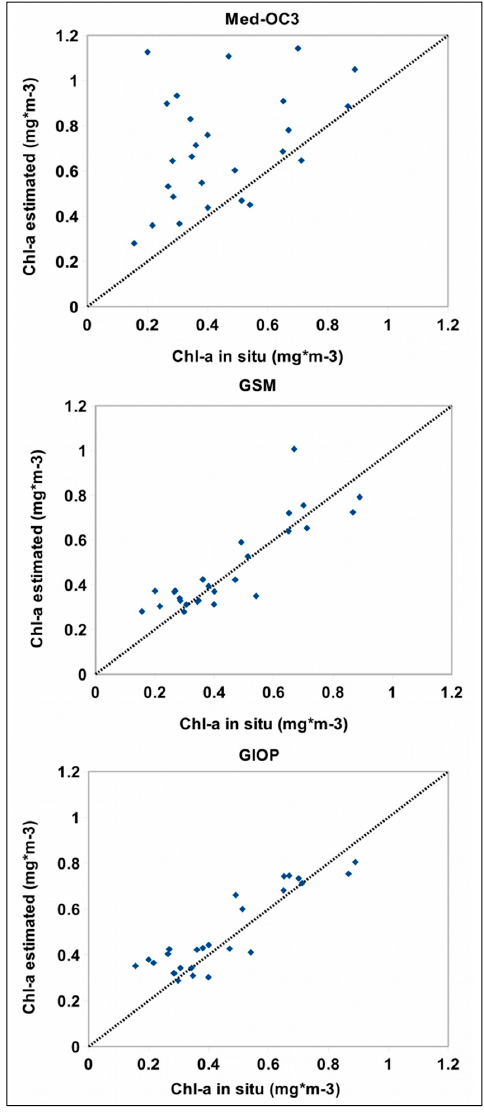
Figure 4. Scatter plots of in situ versus MODIS-A chl-a values for Med-OC3, GSM, and GIOP algorithms. In each plot, the dashed line is the 1:1 line.